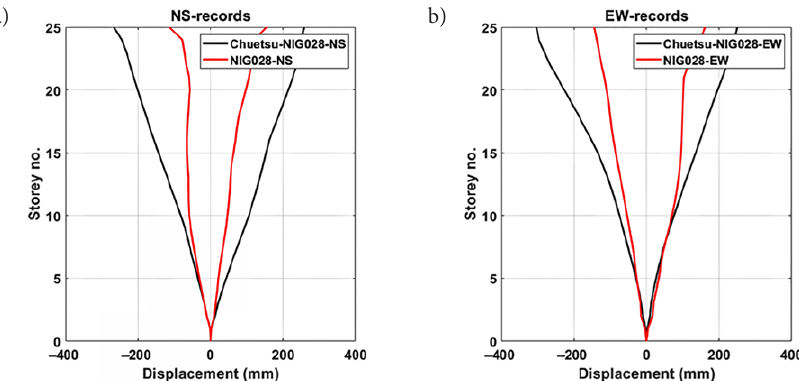
Figure 9. Peak story displacement curves vs. story number under the NS and EW components of the Niigata records with and without sequences in the: a – transverse direction and b – longitudinal direction